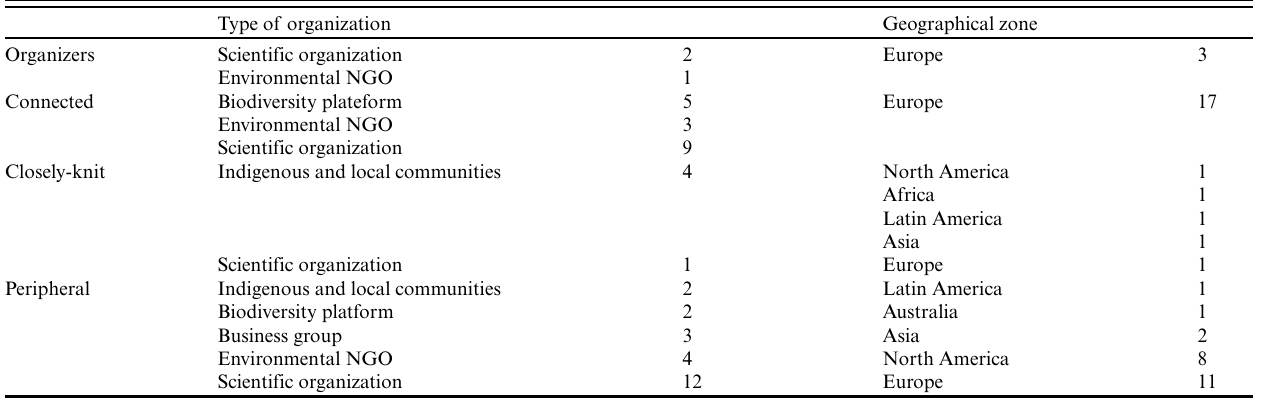
Table 2 . Composition of the subgroups according to the type of organization and geographical